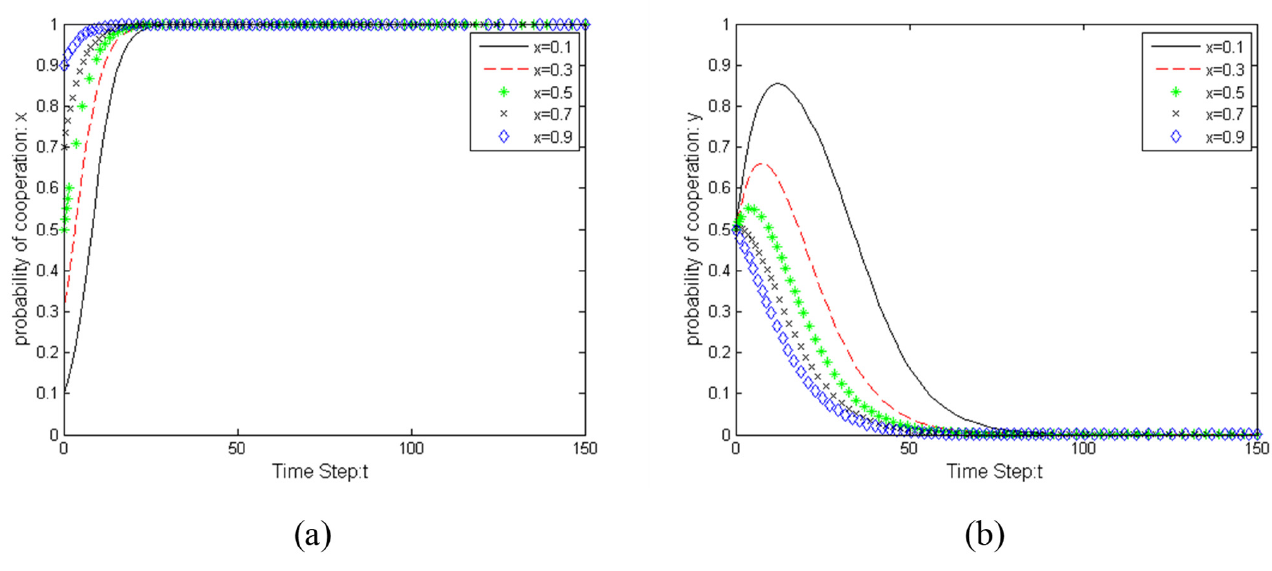
Figure 1. Evolution simulation, Scenario 1: ( a ) RDP; ( b ) hydropower developer.